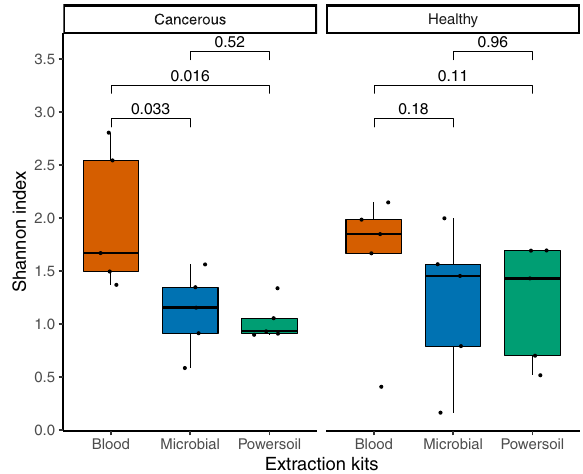
Fig. 1 Shannon ’ s alpha diversity of the tissue samples by type of tissue and extraction kit. Double-sided paired sample t -tests were performed to account for the patient variable. The boxes and bars display the data range, quartiles, and median; n = 5 pairs of tissues (cancerous and healthy) from fi ve different patients extracted by three distinct methods (total of 10 tissues, total of 30 extracts).